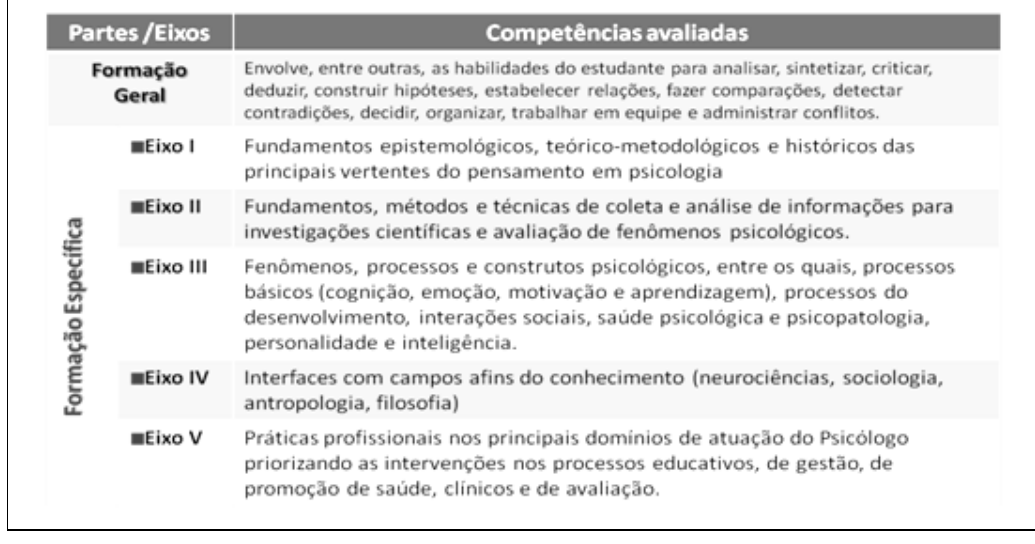
Figura 4 . Estrutura da avaliação (Retirado de Bastos, 2007, slide